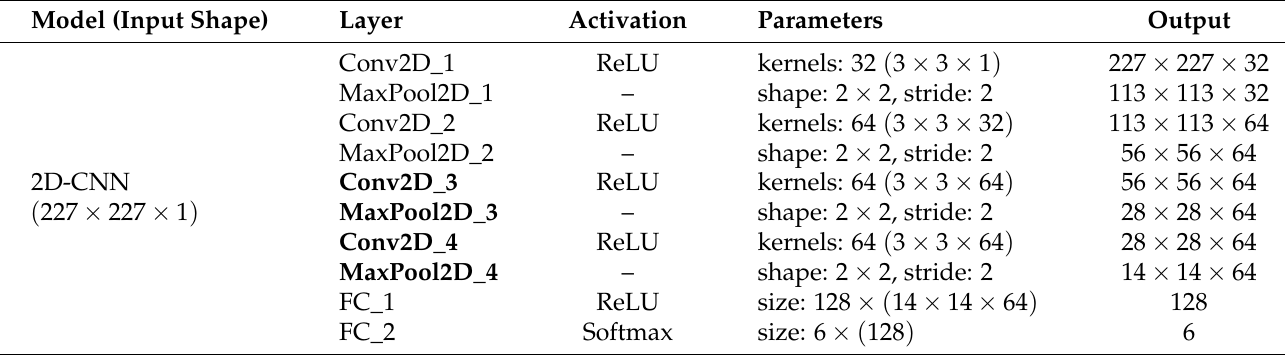
Table 3. The Deep Mars architecture utilized for classifying Mars images. The bolded layers have been added during the model reshaping, as discussed in the following part of the manuscript (Section 3).